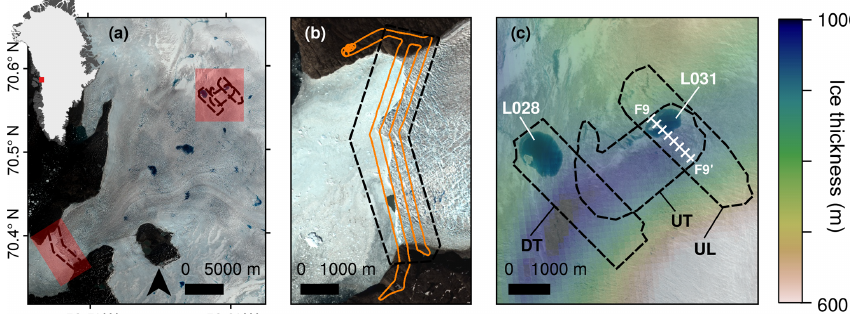
Figure 1. Location of study sites. (a) Store Glacier with calving front and inland study sites highlighted. Inset: location of Store Glacier in Greenland. (b) Calving front flight zone with example flight path shown. (c) Inland flight zones labelled with names: downstream transverse (DT), upstream longitudinal (UL), and upstream transverse (UT). Transect F9 marks location of Fig. 9. Ice thickness from BedMachine v3 (Morlighem et al., 2017) is overlaid, and supraglacial lakes at the inland study site (L028 and L031) are also labelled.